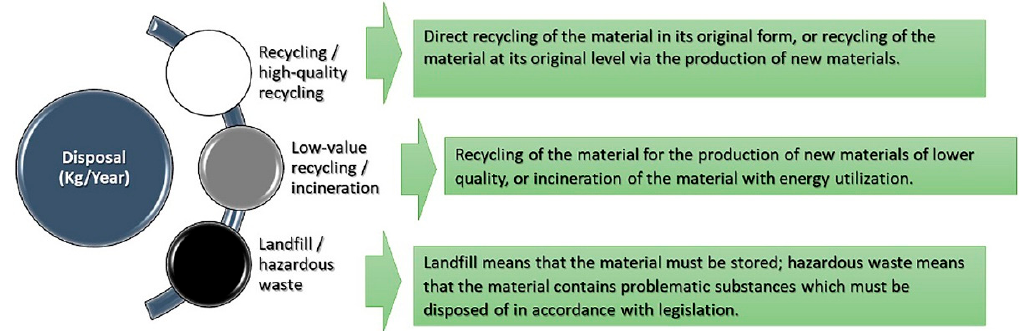
The last indicator of the environmental profile (EP) shows the building, construction, or material when its service life is over (see Figure 11).